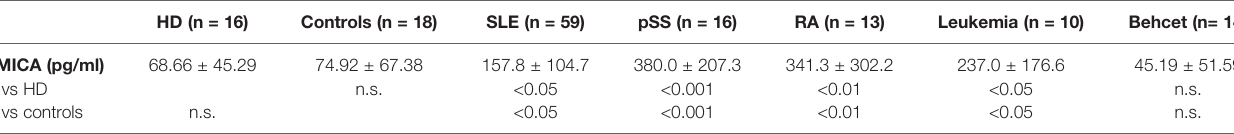
TABLE 1 | Concentrations of soluble MICA in the serum of healthy individuals and patients with diverse